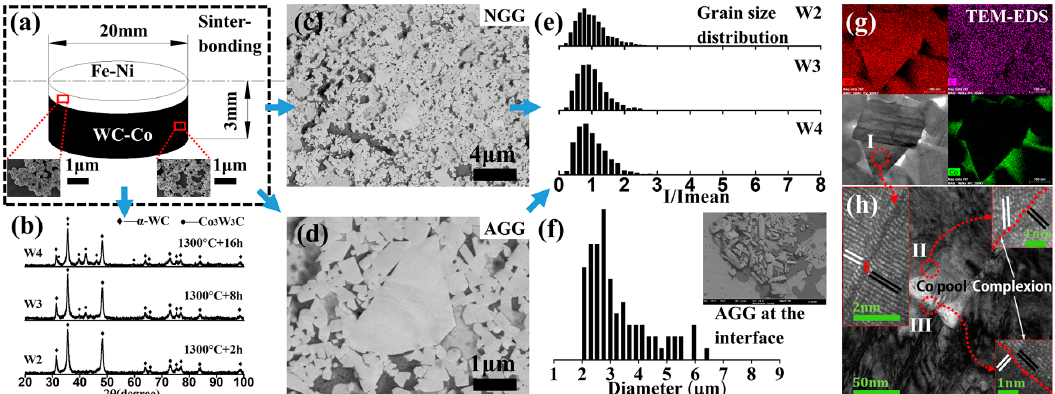
Figure 1. Sinter-bonding of WC–Co cemented carbide and Invar alloys. ( a ) Schematic illustration of sinter-bonding process. ( b ) X-Rays Di ff raction (XRD) patterns of sinter-bonded joints. ( c ) Normal grain growth. ( d ) Abnormal grain growth. ( e ) Grain size distribution for specimens far from interface and ( f ) at the WC–Co / Fe–Ni interface. ( g , h ) Bright-field Transmission Electron Microscope (TEM) photographs using FEI Titan Themis 200 TEM microscope (FEI, Hillsboro, OR, USA) and high-resolution TEM photographs showing the WC crystal lattices and the formation of intergranular films (complexion) at the WC / Co interface. NGG, normal grain growth; AGG, abnormal grain growth. EDS, energy-dispersive X-ray spectroscopy. Adapted from [24], with permission from Elsevier, 2019.